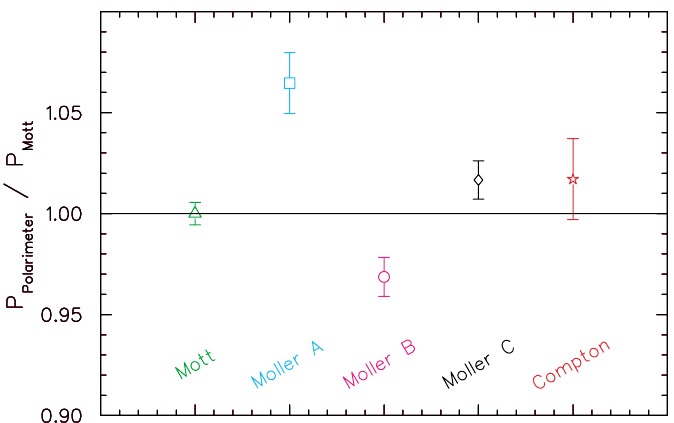
FIG. 9. (Color) The relative analyzing powers for the five Jefferson Laboratory electron beam polarimeters, normalized to the Mott polarimeter for